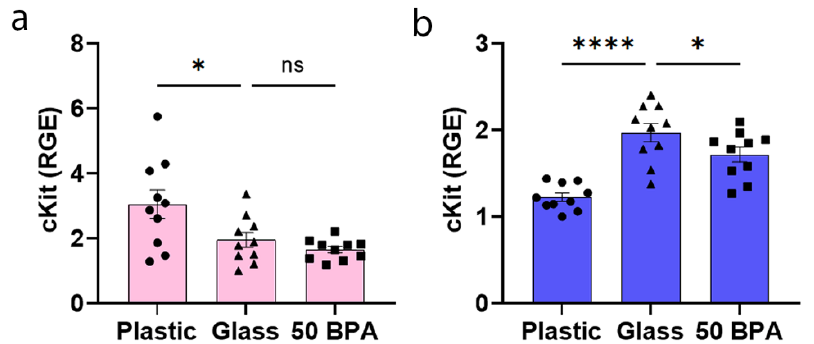
Figure 6. Plastic caging increases the mast cell marker cKit during acute myocarditis in BALB/c females, but decreases its expression in males. ( a ) Female (pink) and ( b ) male (blue) BALB/c mice were given normal drinking water (drinking water that did not contain BPA) for 2 weeks and housed either in glass cages/water bottles (glass) or plastic cages/water bottles (plastic) with soy-free food and bedding. BALB/c mice housed in glass cages/water bottles with soy-free food and bedding were given either normal drinking water (drinking water that did not contain BPA) (glass) or 250 μ g BPA/L water (50 BPA) for 2 weeks. Mice were injected i.p. with 10 3 PFU CVB3 on day 0 and harvested at day 10 pi. The cKit levels in the heart were determined by qRT-PCR for relative gene expression (RGE) compared to the housekeeping gene Hprt. Data shown as scatter plot and mean +/−SEM using one-way ANOVA with Holm –Šídák’s multiple comparisons test with 10 mice/group (* p < 0.05), (**** p < 0.0001).